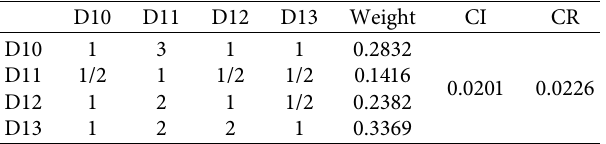
Table 6: Judgment matrix, weight allocation, and consistency test of environmental performance information.